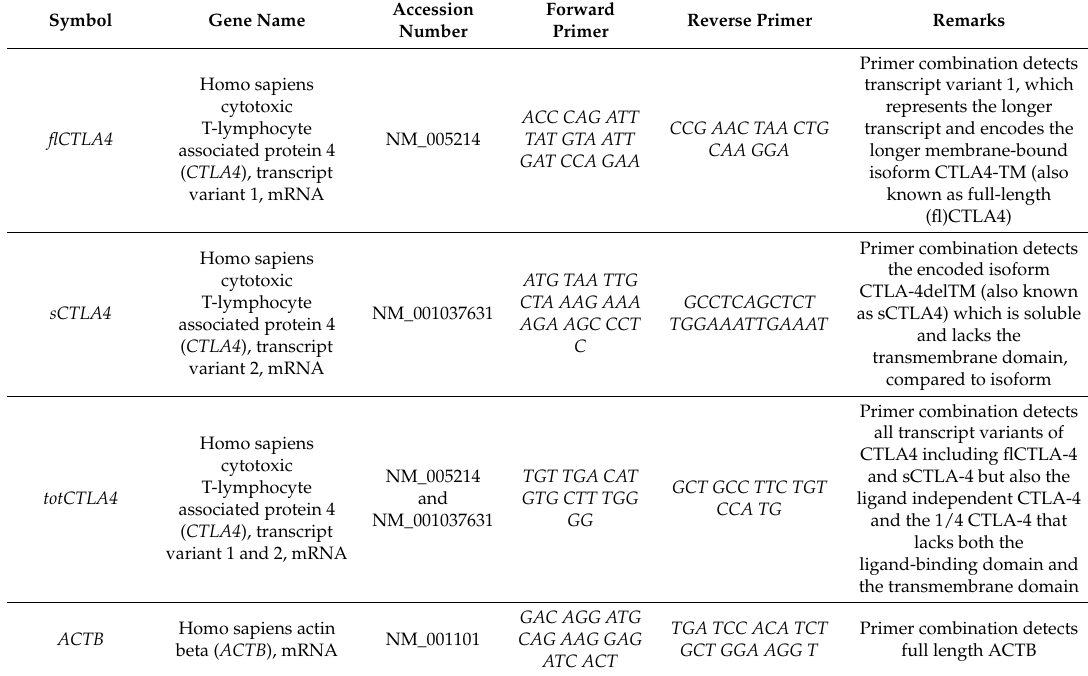
Table 1. qPCR primer